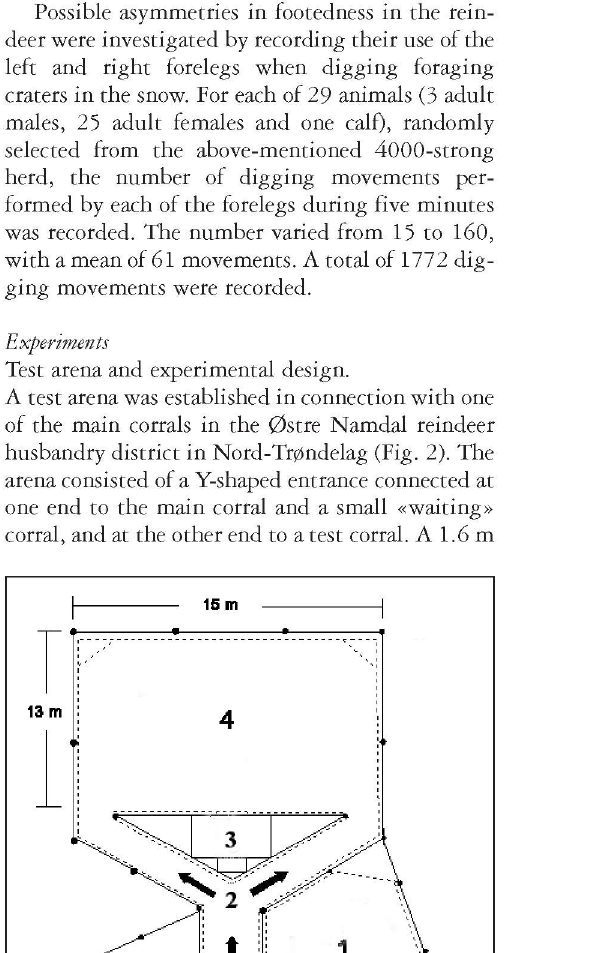
Fig. 2. Test arena used in the field experiments. 1. «waiting» corral, 2. Y-entrance, 3. observation tower, 4. test corral, 5. gates, 6. main